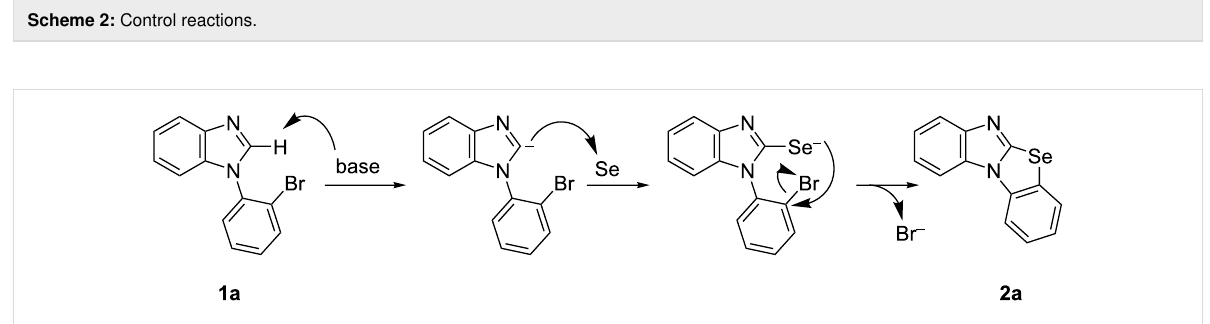
Scheme 3: Proposed mechanism.